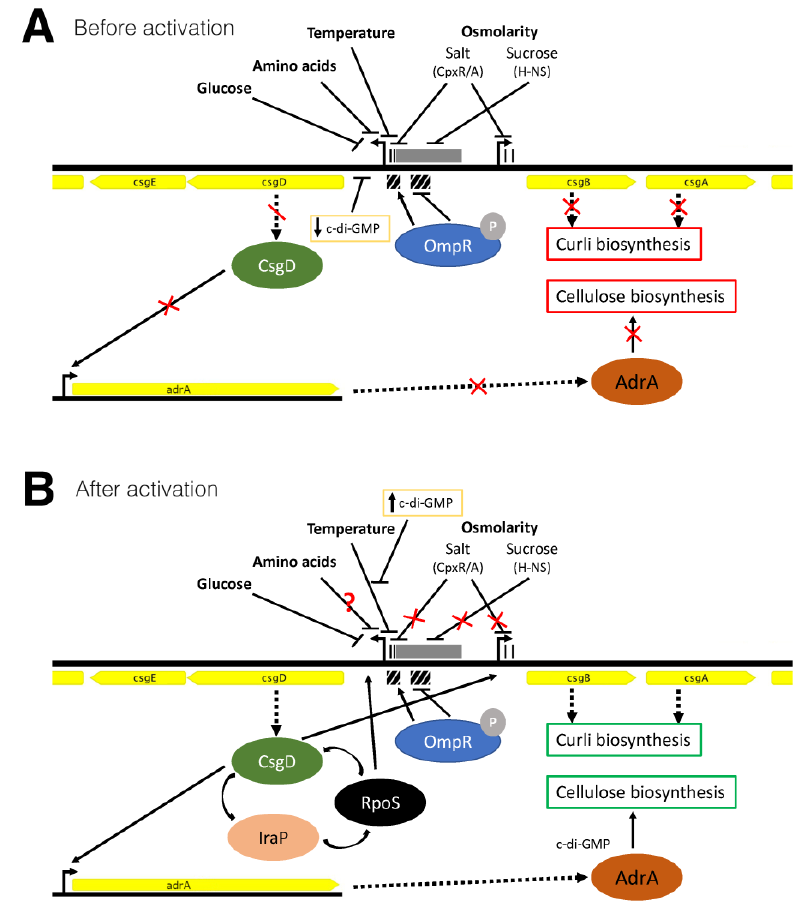
Figure 8. Graphical illustration of the CsgD regulatory principles identified in this manuscript. The divergent csg operons are shown (without csgFG and csgC ) with the intergenic region highlighted by transcription factor binding sites that have been experimentally verified in Salmonella (CpxR—black bars; H-NS—grey box; OmpR—hatched boxes). Phosphorylated OmpR binds the proximal, high a ffi nity site under conditions of low osmolarity, which activates csgD transcription, and binds the distal, low a ffi nity sites under conditions of high osmolarity, which represses csgD transcription [38]. The di ff erent regulatory elements that we have tested are shown: glucose; amino acids; growth temperature; and osmolarity, with sodium chloride, which is known to act via the CpxR / A system [37], and sucrose, which is known to act via H-NS [36]. The adrA gene encodes a diguanylate cyclase, which produces cyclic-di-GMP and allosterically activates cellulose production. ( A ) Glucose ( > 25 mM), amino acids ( > 0.5% casamino acids), temperature ( > 32 ◦ C), salt and sucrose ( > 25 mM) caused a reduction in csgD transcription and blocked transcription of csgBAC and adrA , preventing curli and cellulose biosynthesis. The e ff ect of reduced c-di-GMP was tested by overexpression of the YhjH phosphodiesterase. The addition of individual amino acids was variable, with three leading to reduced csgD transcription (Asn, Pro, Arg), and seven leading to increased csgD transcription (Ile, Val, Gln, Met, Ala, Thr, Gly). ( B ) When the same regulatory components were tested after 18 h of growth, the e ff ects were di ff erent. We assume that by this time point, the CsgD-IraP-RpoS feed-forward loop [35] is activated, although deletion of iraP in our experiments had little e ff ect. The addition of salt and sucrose had no e ff ect on csgD transcription, and casamino acids were not as repressive. The e ff ect of increased c-di-GMP was tested by overexpression of the diguanylate cyclase STM1987, which was able to relieve temperature-based repression of csgD transcription. The response to individual amino acids was again variable, however, none caused a reduction in csgD transcription and eight were stimulatory (Leu, Arg, His, Val, Pro, Ala, Gln, Thr). The question mark signifies that we do not fully understand the regulatory e ff ects of individual amino